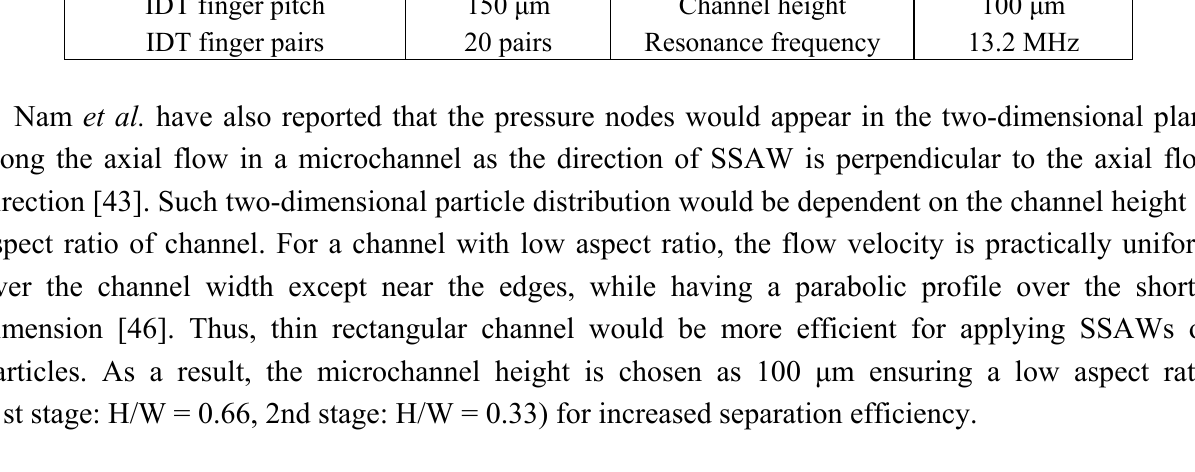
Figure 5. Fabrication process flow of sheathless acoustic particle separator using